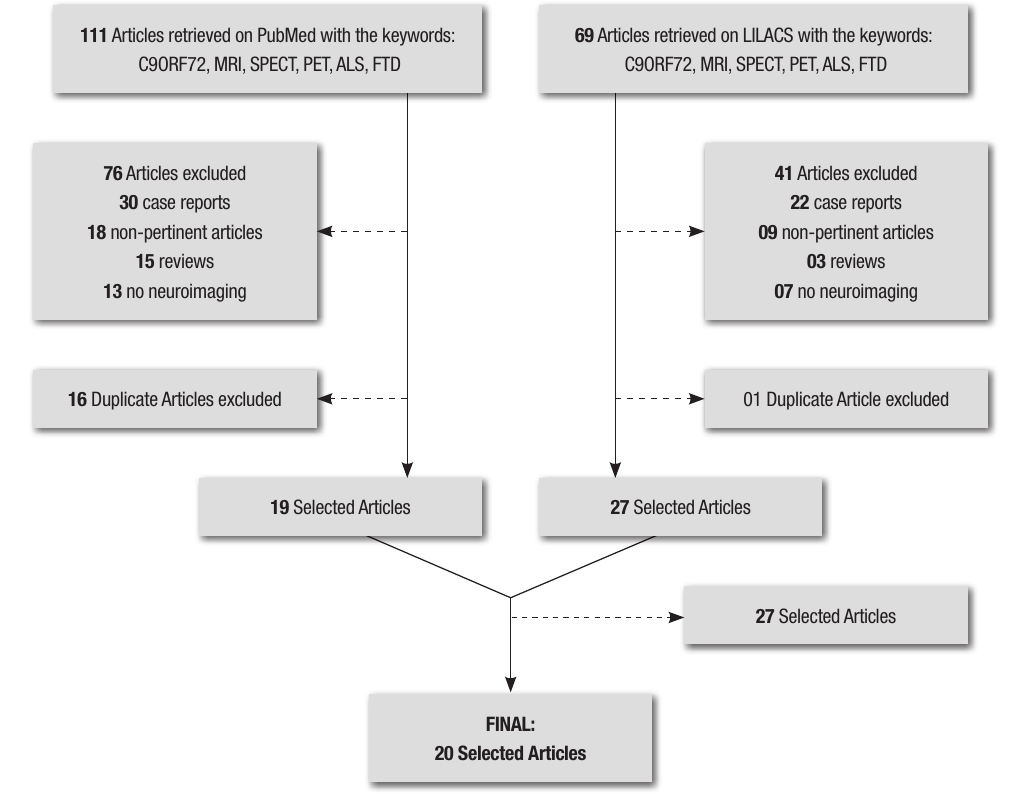
Figure 1. Flowchart depicting selection of items for systematic review on PubMed and Lilacs databases using the terms C9ORF72, ALS, FTD, MRI, SPECT and